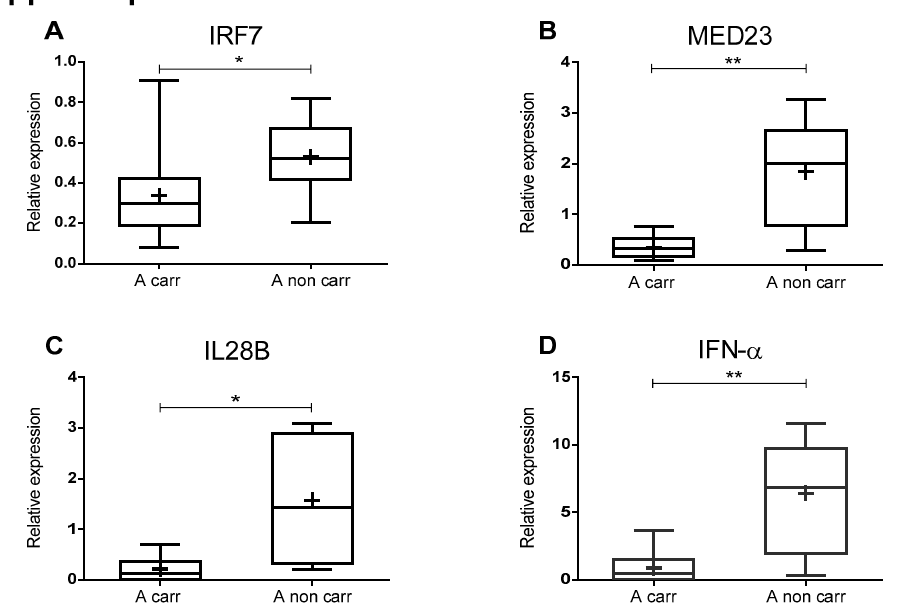
Figure 3. Effect of IRF7 (rs6598008) SNP on antiviral immune gene expression of AD patients. qPCR data showing relative expression (2 - ∆ Ct values using CYC1 and EIF4A2 as reference genes) of IRF7 ( A ), MED23 ( B ), IL28B ( C ), IFN- α ( D ) in the hippocampus of AD patients grouped in A carrier / or A noncarrier. Data from each group are shown as a box and whiskers plot with the ends of the whiskers represent the minimum and maximum data values, the horizontal line represents the median, and the “ + ” represents the mean relative expression values. * p < 0.05 ** p < 0.01 (unpaired t